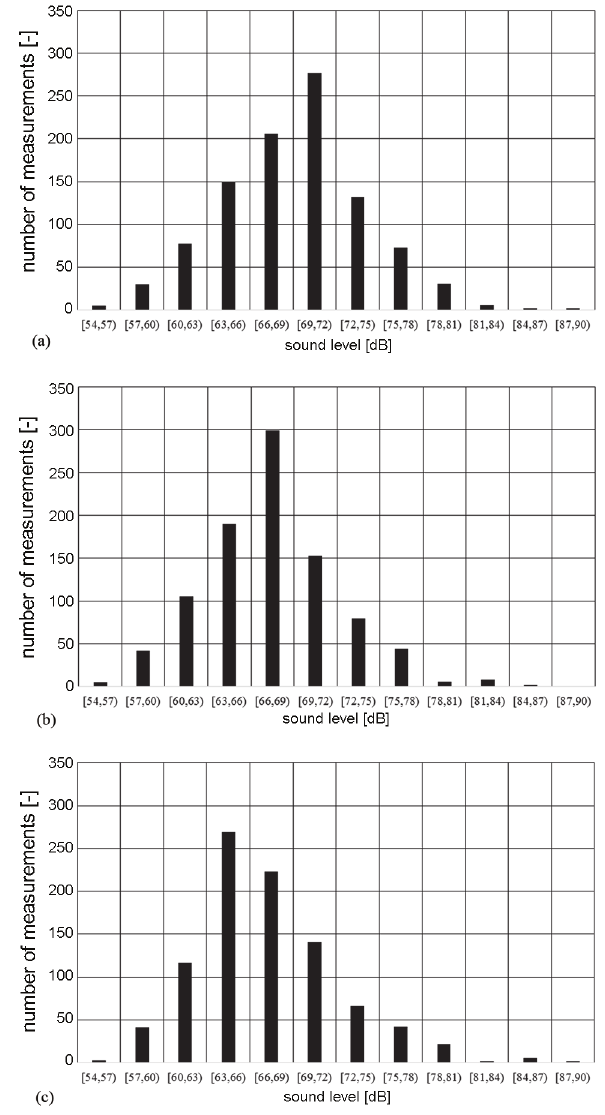
Figure 3. The values of the equivalent sound level L Aeq , T recorded on scaffolds for one selected city at: (a) – 8 AM; (b) – 11 AM; (c) – 2